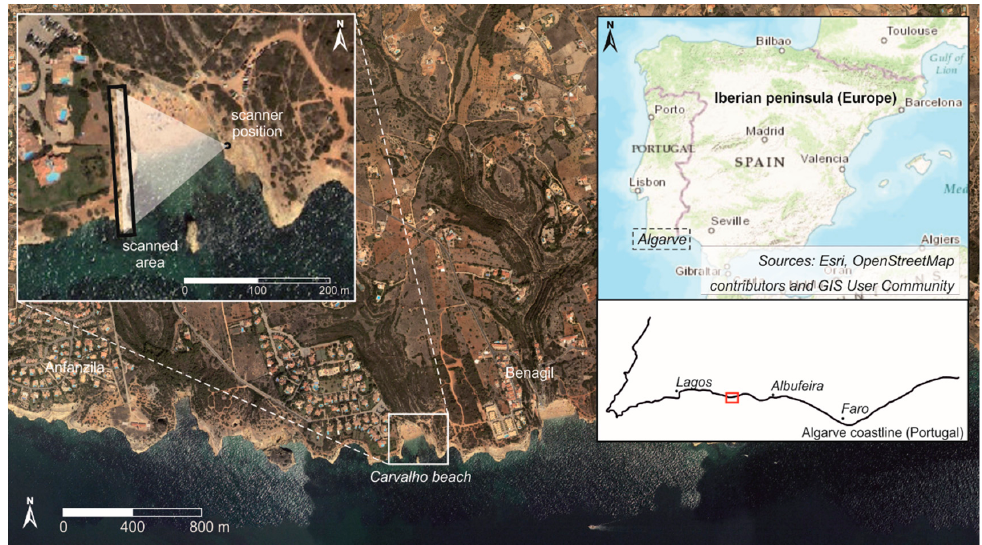
Figure 1. Location of the study area and scanner position (zoomed map image) during the site survey. Carvalho Beach is located within the white frame, between Benagil and Anfanzila.